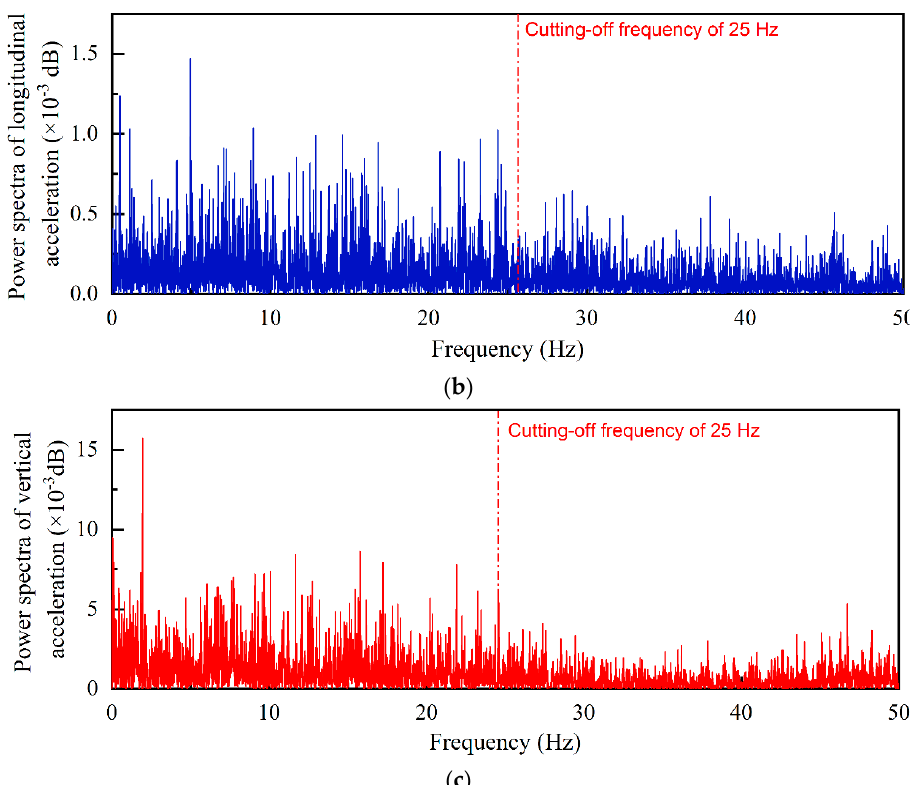
Figure 9. Examples of the power spectra of normalized acceleration data recorded by #R2 in three different dimensions: ( a ) Lateral, ( b ) Longitudinal, and ( c ) Vertical.